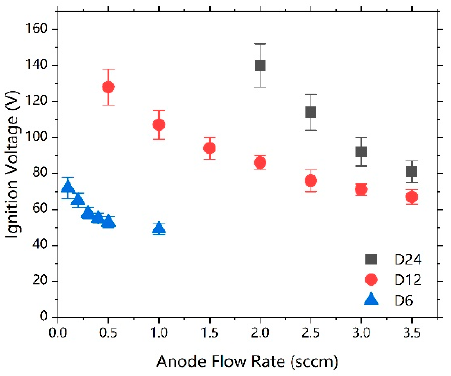
Figure 14. Ignition anode voltages of thrusters with different channel diameters (24 mm, 12 mm and 6 mm) and the same channel length (60 mm).